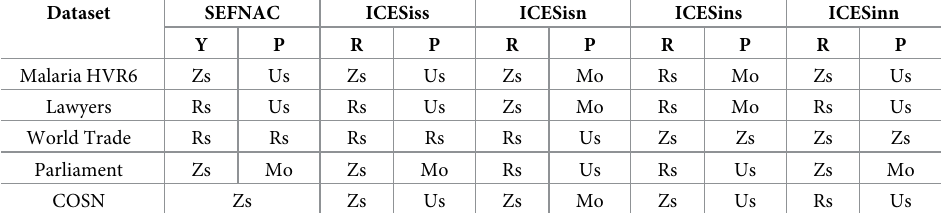
Table 8. Standardization options chosen for the least-squares community extraction methods at the real world datasets. Dataset